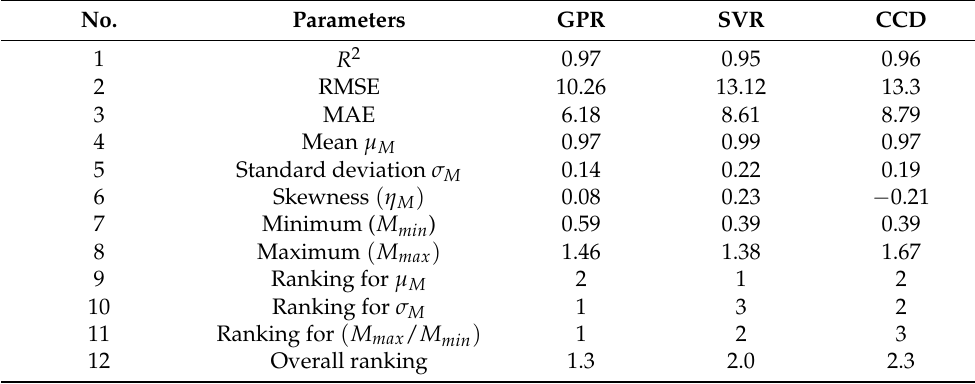
Table 4. Statistical properties of the resistance models (using the testing dataset).